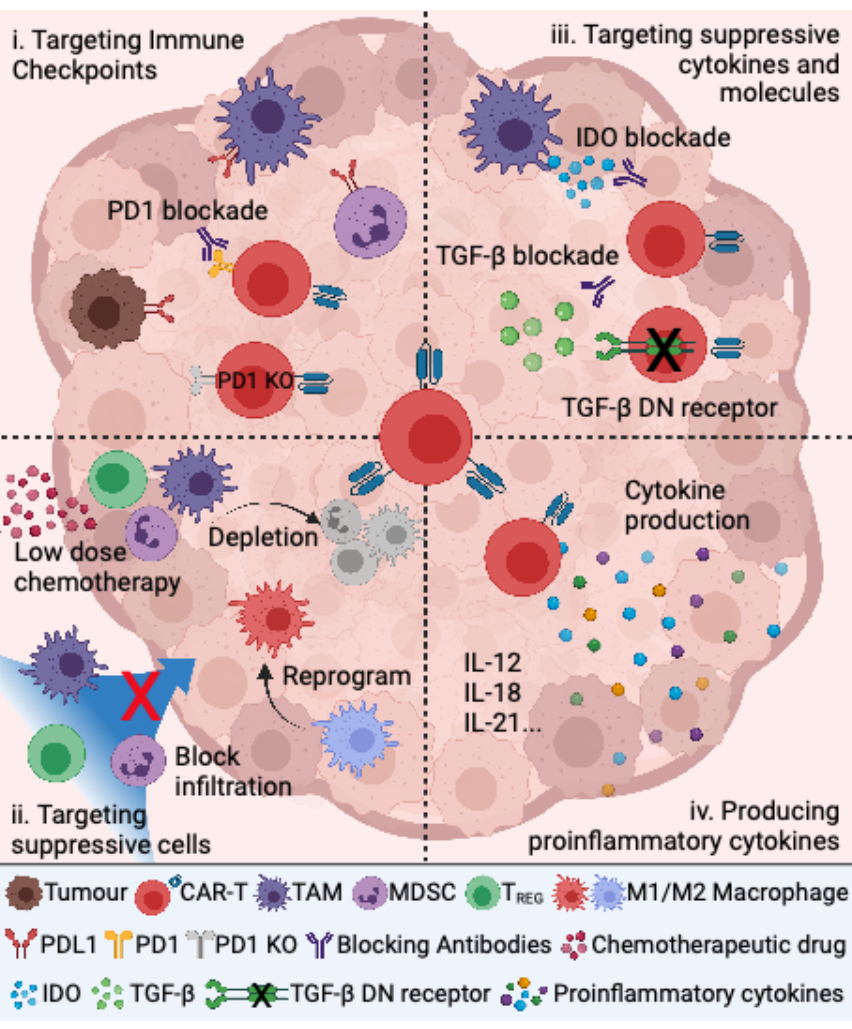
Figure 1. Strategies for addressing tumor-induced immune suppression in combination with CAR T cells to treat pediatric sarcoma. cells to treat pediatric